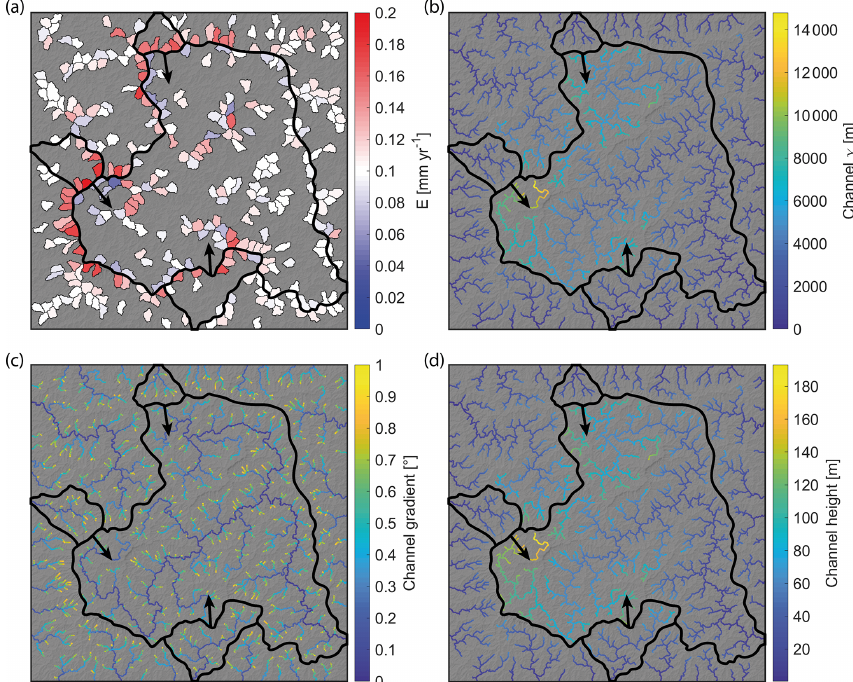
Figure 6. Denudation rates and cross-divide contrast metrics obtained for the reference model after 2.5Myr of simulation. Drainage network is extracted from a minimal drainage area of 1km 2 . (a) Map of denudation rates for basins of 2–4km 2 . Thick black lines correspond to basin divides in Fig. 2d. Black arrows, show the direction of divide migrations for three selected basins; (b) χ map; (c) channel gradient map; (d) channel height